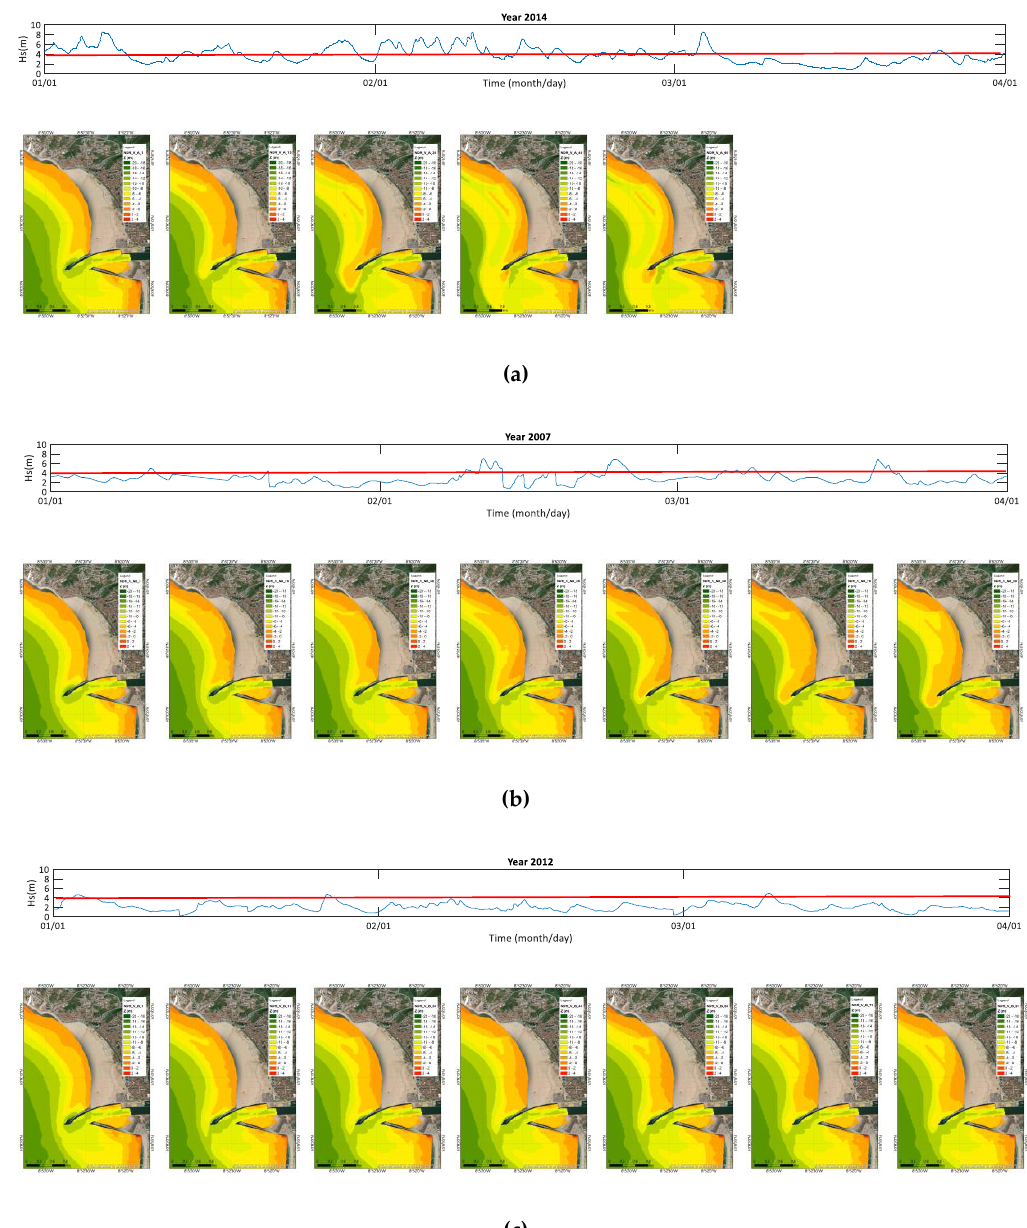
Figure 4. Evolution of bathymetry in the reference scenario depicted with an interval of 15 days for each wave climate scenario: ( a ) high-energy wave (2014), ( b ) medium-energy wave (2007), ( c ) low-energy wave (2012). Note: significant wave height distribution o ff shore over time is included with a red line that represents the storm threshold ( i.e. Hs >4m).